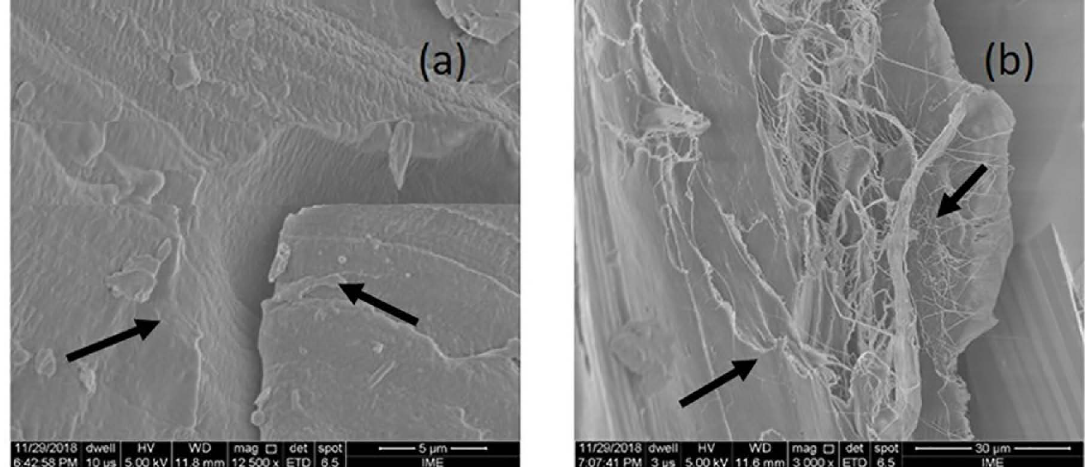
Figure 8. SEM images, after the first impact, of the distal face (a) of an A80/00 sample showing the microcracking without pullout and (b) of an A80/50 sample showing microcracking with pullout.